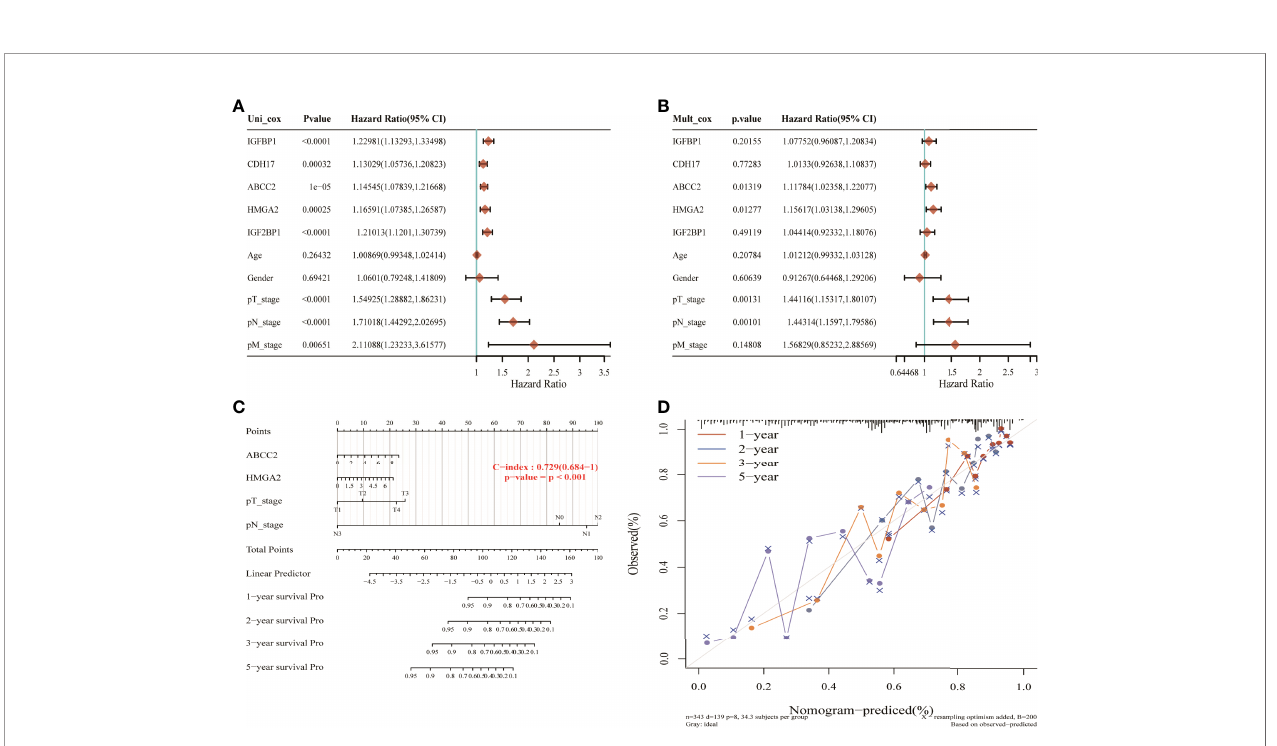
FIGURE 8 | Nomogram construction of nitrogen metabolism genes in lung adenocarcinoma. (A, B) ABCC2, HMGA2M, T, and N stages were identi fi ed as four independent prognostic risk factors. (C) The nomogram constructed using ABCC2, HMGA2M, T, and N stages with C-index of 0.729 illustrated the model reliability. (D) The correction curves for 1, 2, 3, and 5 years showed good fi t of the